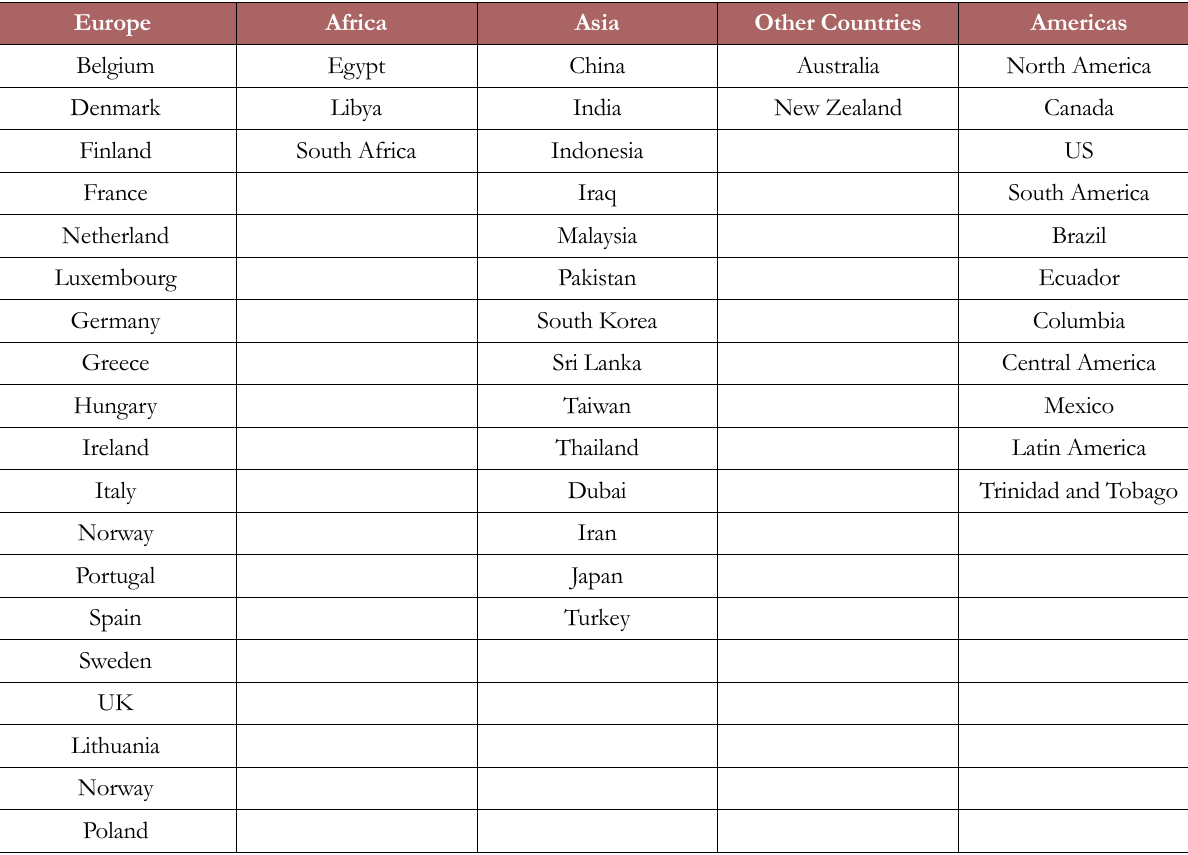
Table 6. Regional distribution of Lean